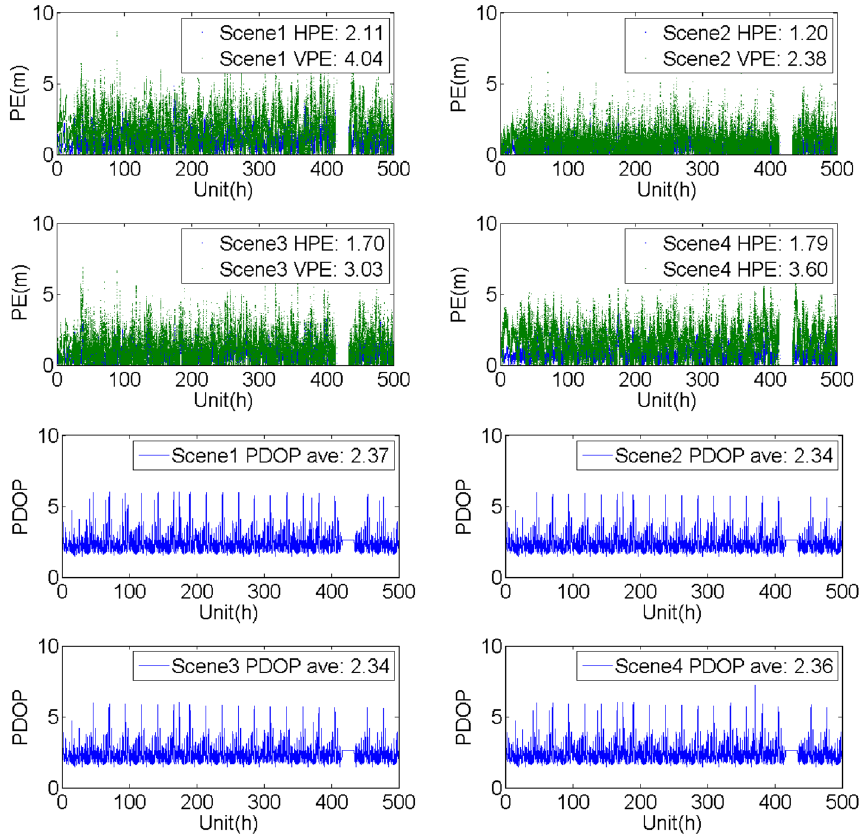
Figure 10. Evaluation of the PE and PDOP under different scenes in Chengdu known point from Dec 11 to 31,